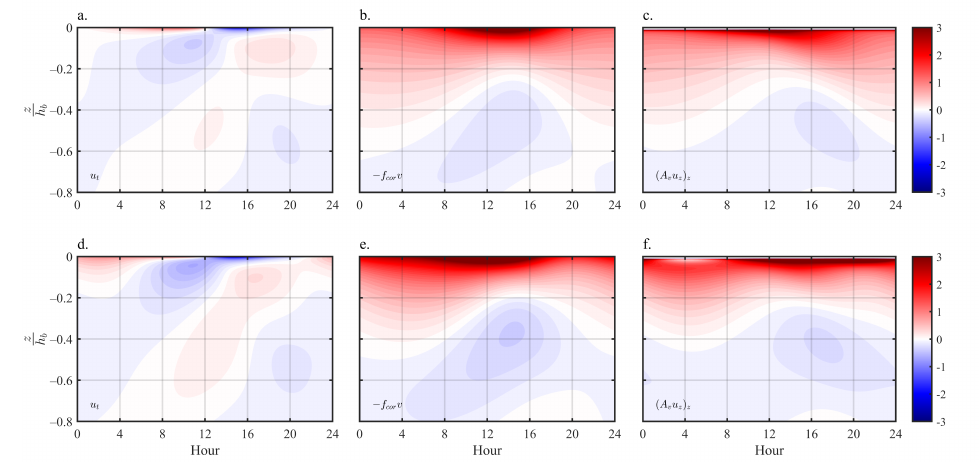
Figure 8. Zonal momentum balance terms from the case in Figure 7, without CSF (top, ( a – c )) and including CSF (bottom, ( d – f )), with values normalized by | τ a | /